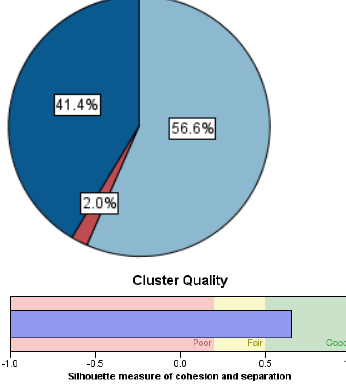
Figure 3 . Cluster size and quality